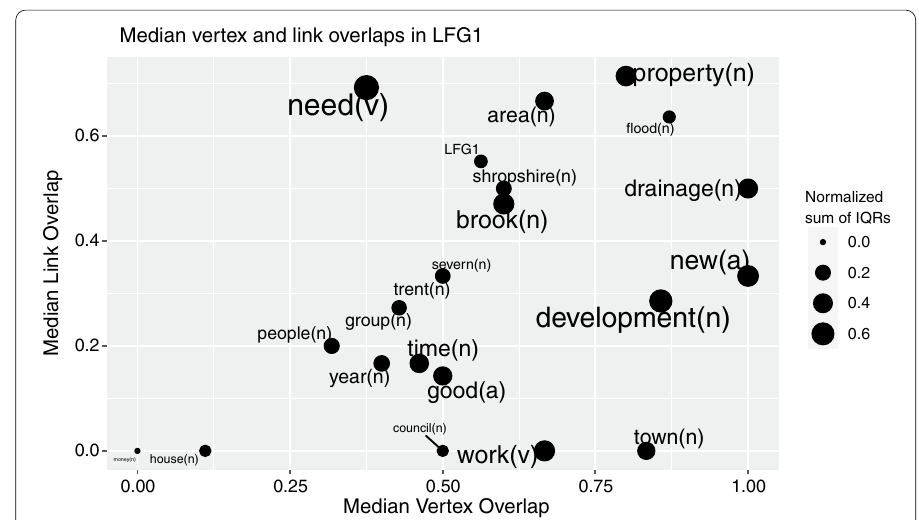
Fig. 13 Median vertex and link overlaps for the actors’ in LFG1. The size of the dot reflects the variability in the concept’s vertex and link overlaps in this